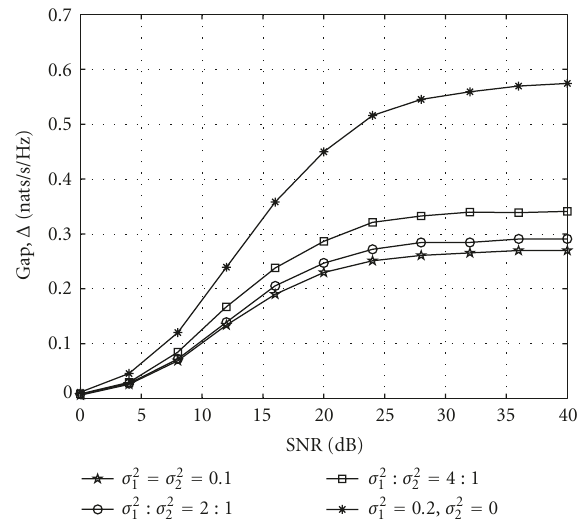
Figure 2: Gap between the mutual information bounds for D- STBCs with two receive antennas; σ 2 1 + σ 2 2 = 0 .